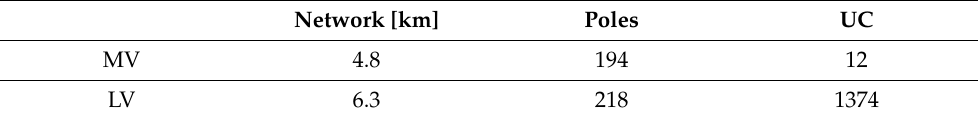
Table 5. Feeder- β data.